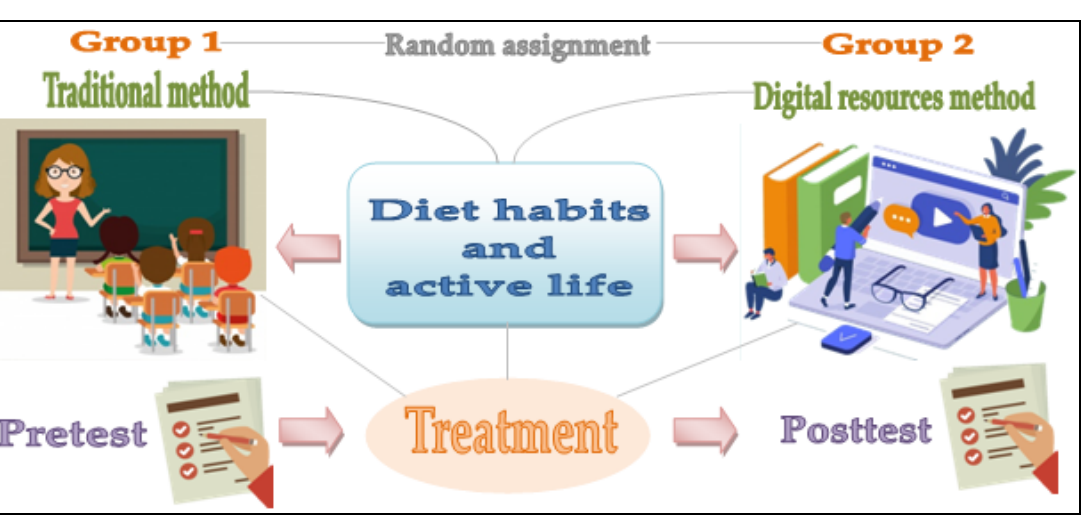
Figure 1. Graphic description of the research design.